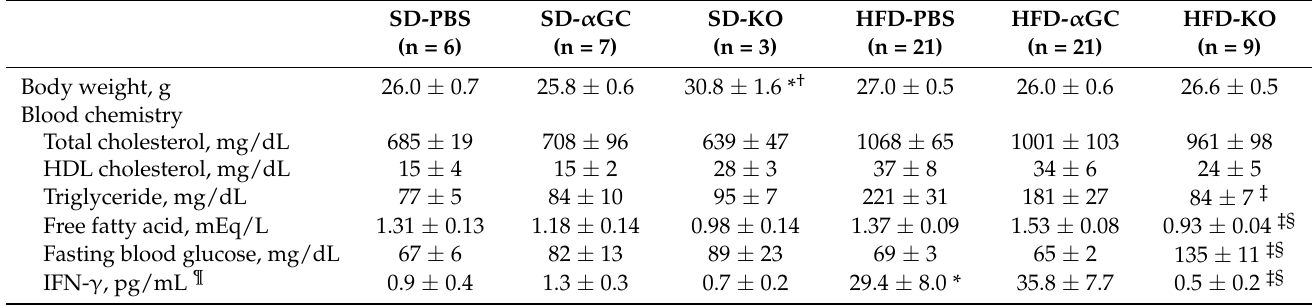
Table 1. Animal characteristics.